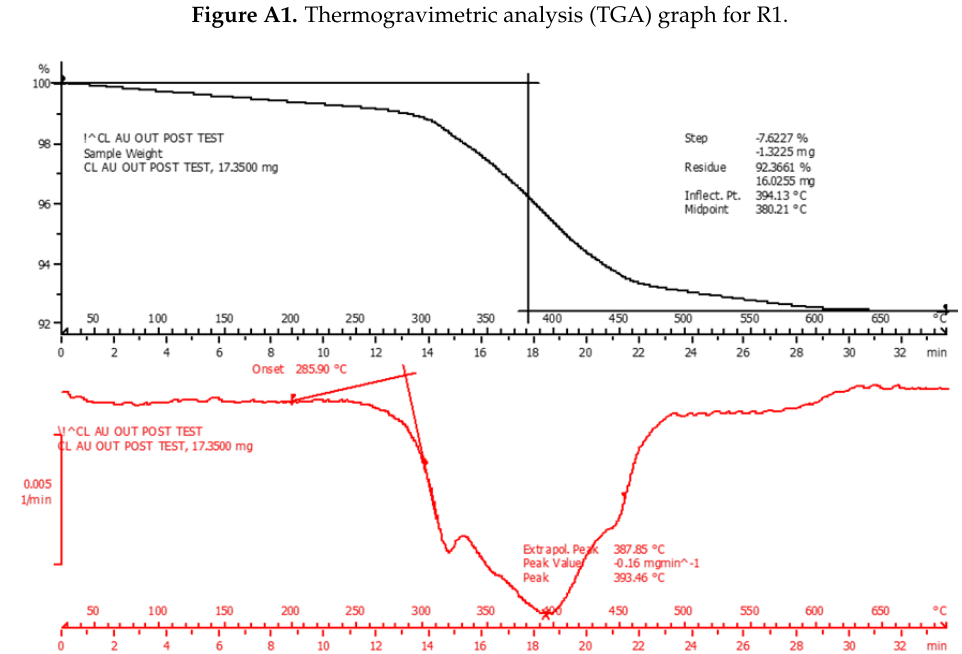
Figure A2. TGA graph for R2.